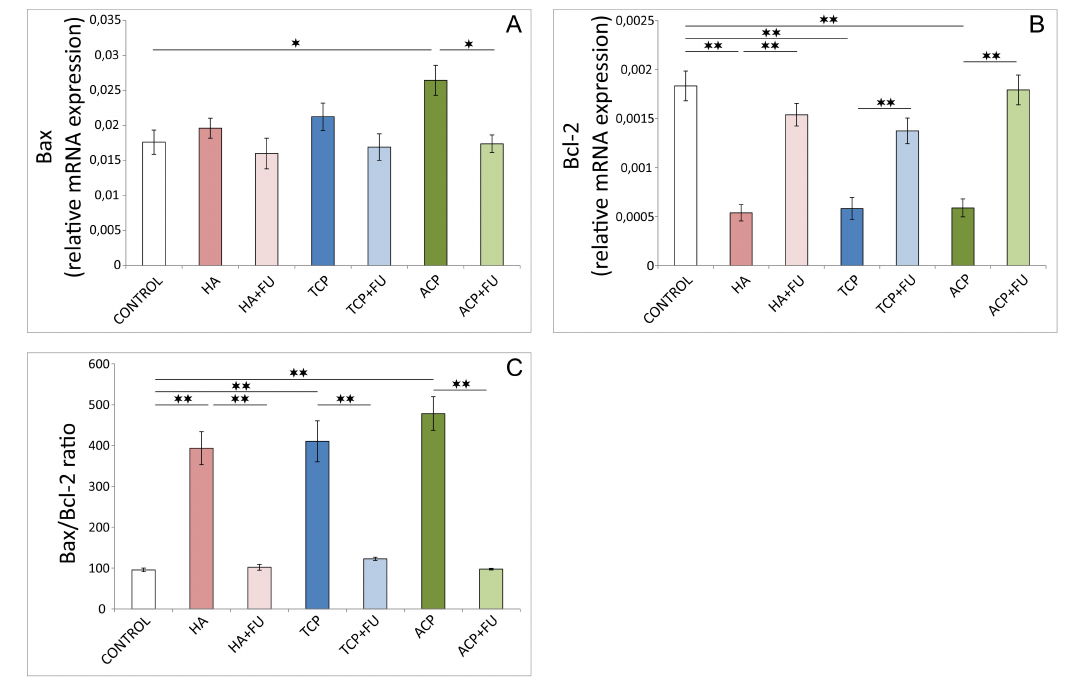
Fig.4. Pro-andanti-apoptoticrelativegeneexpressioninthehippocampus(6pergroup). (A)Bax. (B)Bcl-2. (C)Bax/Bcl-2ratio. HA–hydroxyapatite; HA + FU – hydroxyapatite and Filipendula ulmaria extract; TCP – tricalcium phosphate hydrate; TCP + FU – tricalcium phosphate hydrate and Filipendula ulmaria extract; ACP – amorphous calcium phosphate; ACP + FU – amorphous calcium phosphate and Filipendula ulmaria extract. The graph bars present mean ± SEM, * represents a significant difference p < 0.05, ** represents a significant difference p < 0.01.